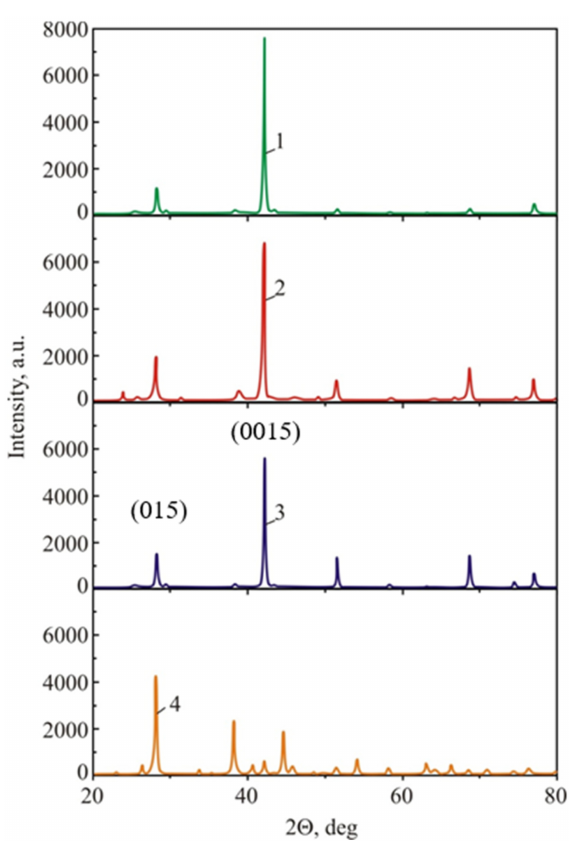
Figure 6. X-ray diffractograms of Bi 2 Te 3 -based compounds prepared by different techniques; 1— p -type Bi 0.5 Sb 1.5 Te 3 prepared by Float zone technique [41]. 2— n -type Bi 2 Te 2.7 S 0.3 prepared by hot extrusion. 3— p -type Bi 0.5 Sb 1.5 Te 3 prepared by hot extrusion. 4— p -type Bi 0.5 Sb 1.5 Te 3 prepared by SPS technique